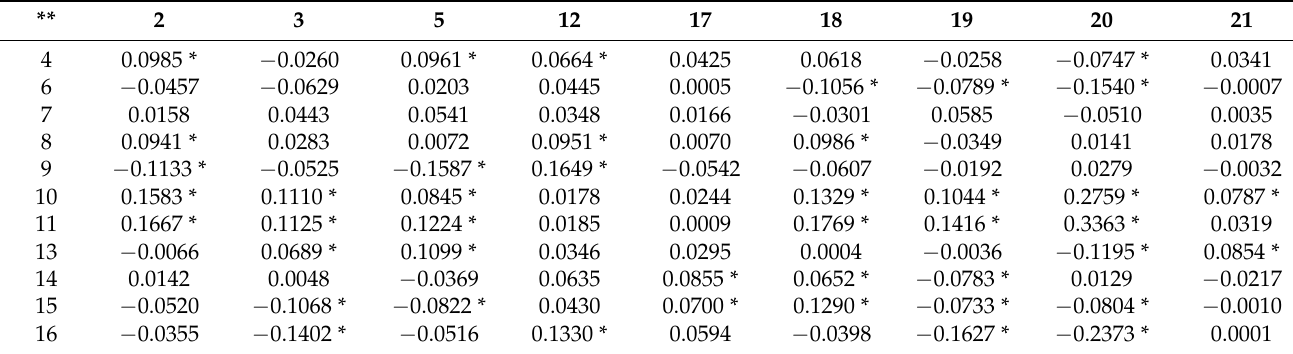
Table 10. The values of Pearson’s correlation coefficients between the assessments of individual theses * (own